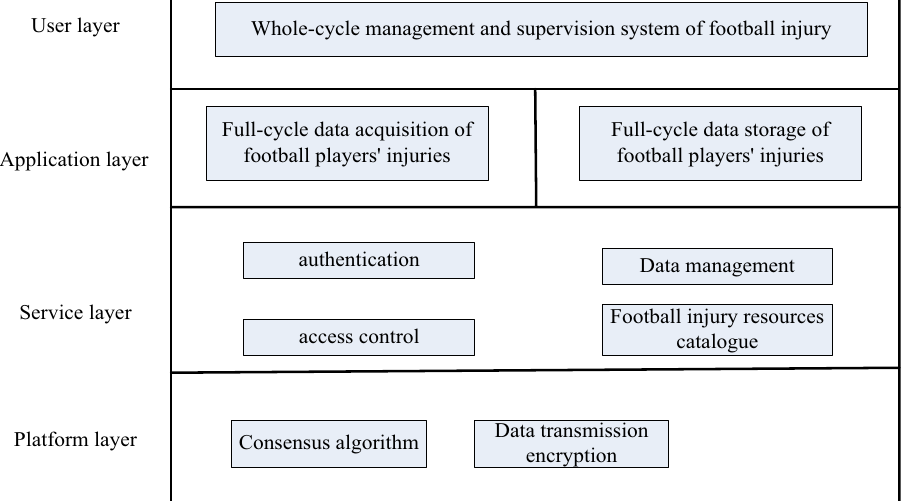
Fig. 2 Blockchain structure model